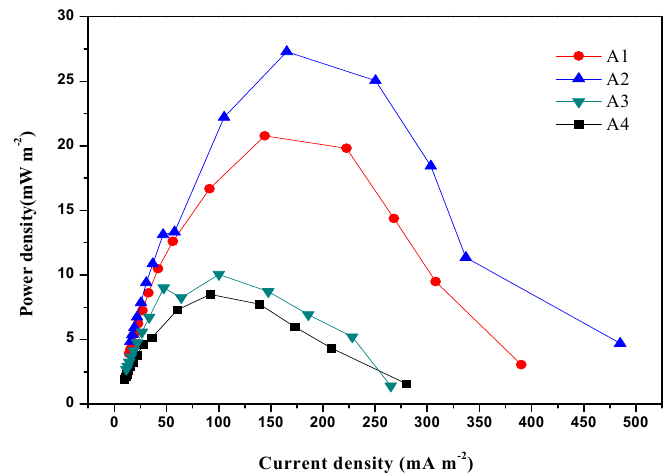
Figure 3. Power–density curves during start-up (A1: 0.1 g zero-valent iron; A2: 0.5 g zero-valent iron; A3: 1 g zero-valent iron; A4: no zero-valent iron).